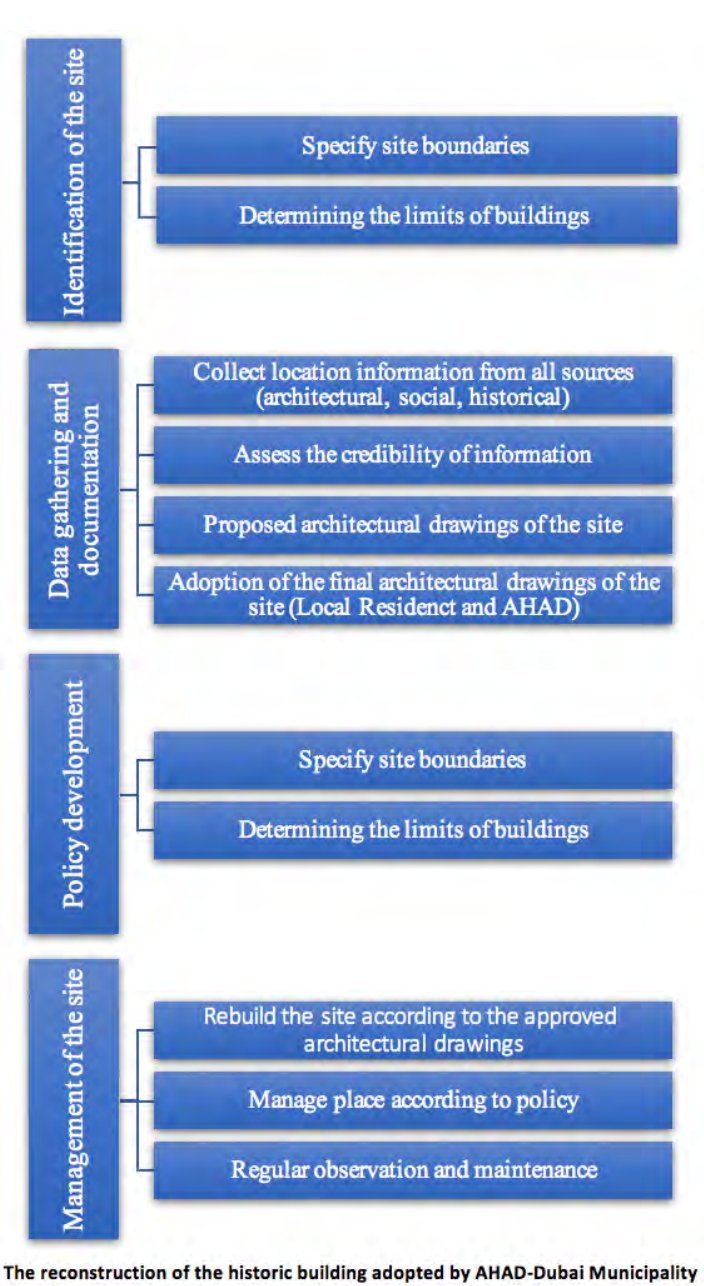
Figure 3. The Polices to reconstruction of the historic Building adopted by AHAD-Dubai Municipality. (Assi, E. & Rajab, M,